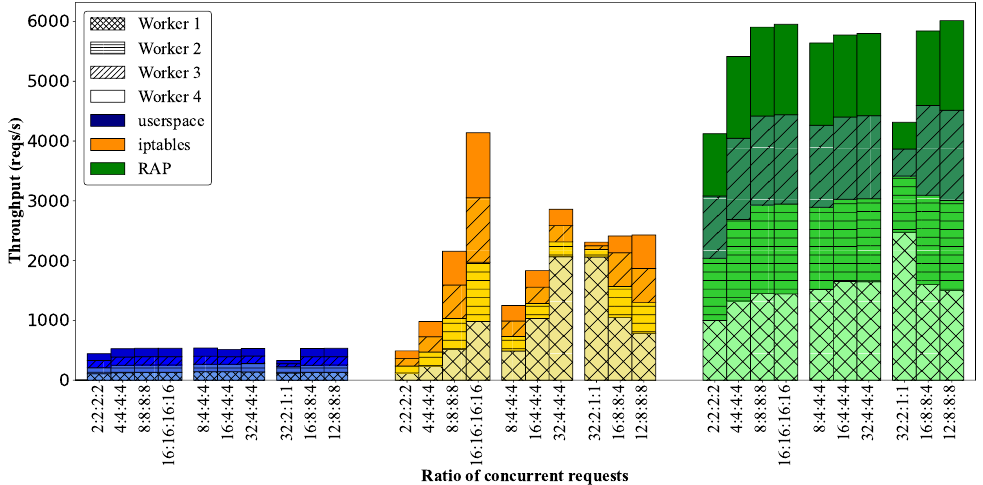
Figure 8. Total throughput of cluster in the distributed request